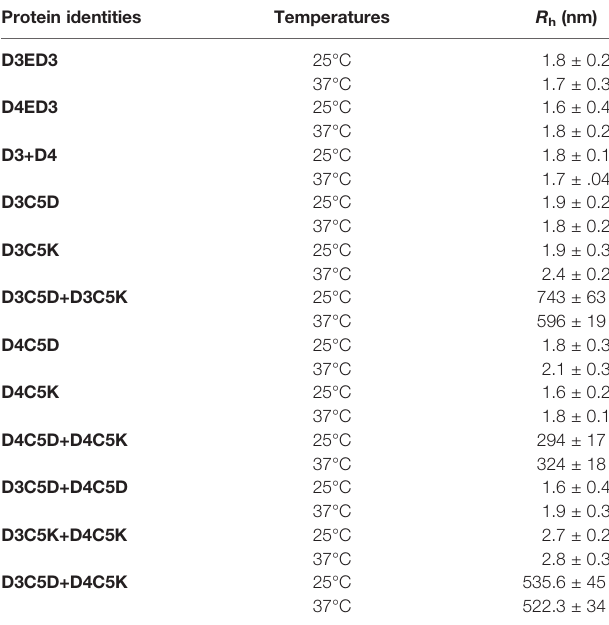
TABLE 1 | Hydrodynamic radii ( R h ) of sub-visible aggregates of the tagged ED3s. Protein